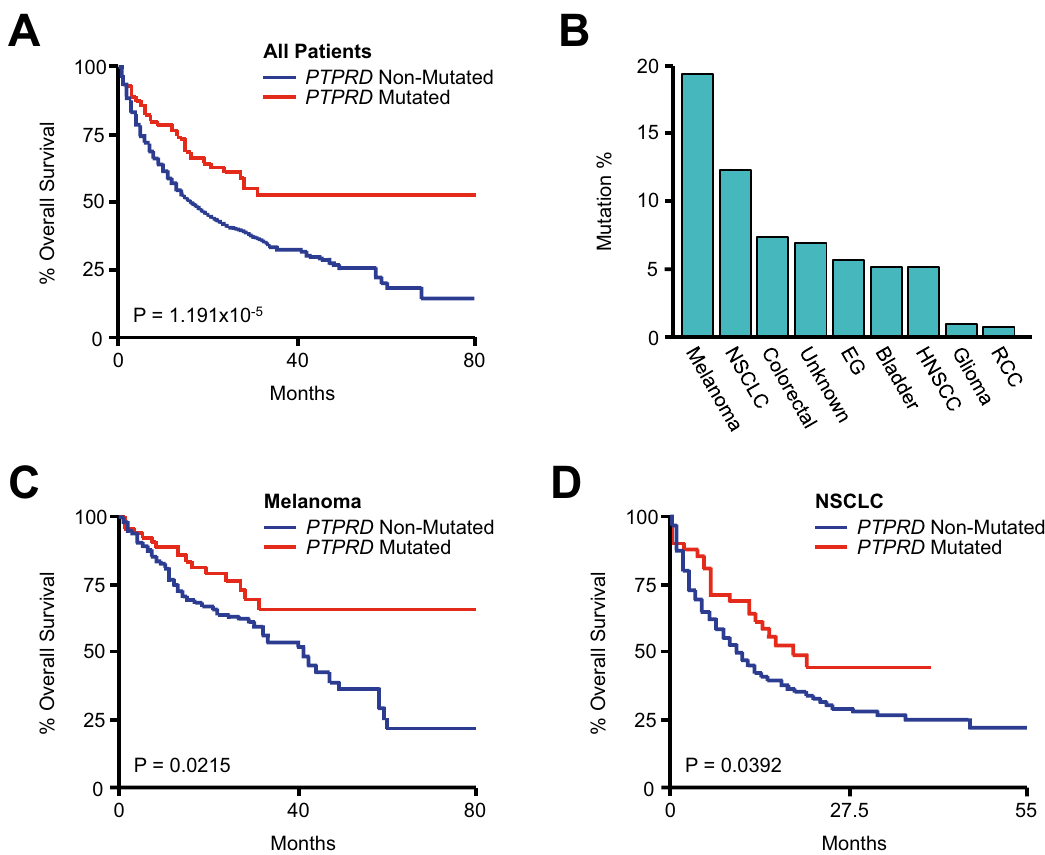
Figure 5. PTPRD mutations are associated with improved survival in melanoma and lung cancer patients receiving immune checkpoint inhibitors. ( A ) Kaplan Meier plot showing overall survival for the pan-cancer cohort (N = 1661) arranged by PTPRD mutation status (148 PTPRD -mutated and 1513 PTPRD -non-mutated patients). ( B ) The percent of PTPRD -mutated patients arranged by tumor type. ( C , D ) Overall survival for the melanoma (N = 320, 63 PTPRD -mutated and 257 PTPRD -non-mutated patients) and non-small cell lung cancer (NSCLC) (N = 350, 43 PTPRD -mutated and 307 PTPRD -non-mutated patients) cohorts arranged by PTPRD mutation